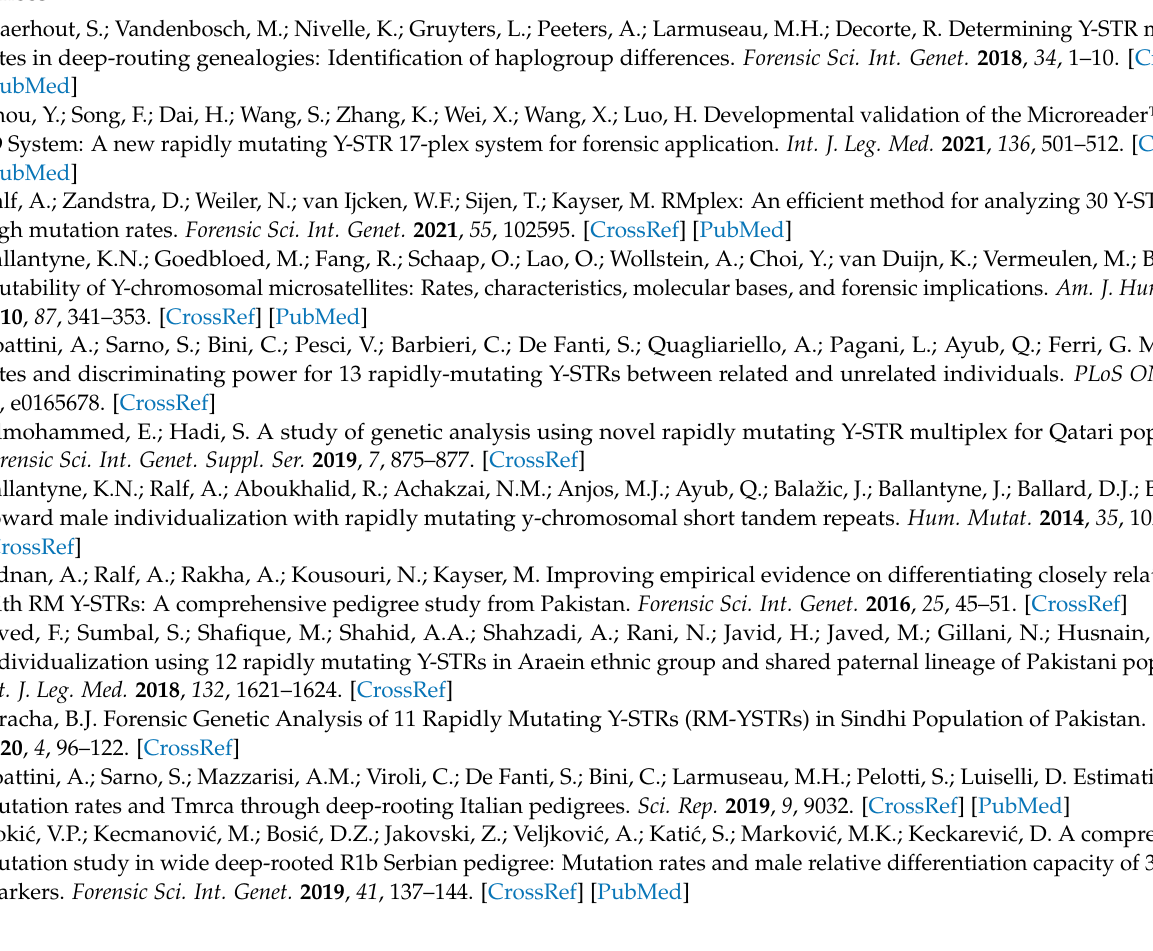
STR multiplex at varying primer concentration (0.31 µ M–0.65 µ M); Figure S3: Serial dilutions of 2800M control DNA display a gradual decrease in RFU with decrease in concentration; Figure S4: (A) Hexaplicate alleles observed at DYS464 and DYF387S1 (B) Triplicate allele observed at DYF404S1; Figure S5: (A) Paternal lineages of family ID 53 and (B) family ID 57 has been illustrated as represent- ing mutation at one or more loci with red symbols while subtext showing the alleles; Table S1: RM Y STR primer sequences, repeat structures and allelic size ranges; Table S2: Pedigrees and sample information along with no. of generations, meiosis, pairwise meiosis and their mutations events; Table S3: Copy number variants observed at duplicated loci; Table S4: The mutation rate found in present and previous studies for 19 Y